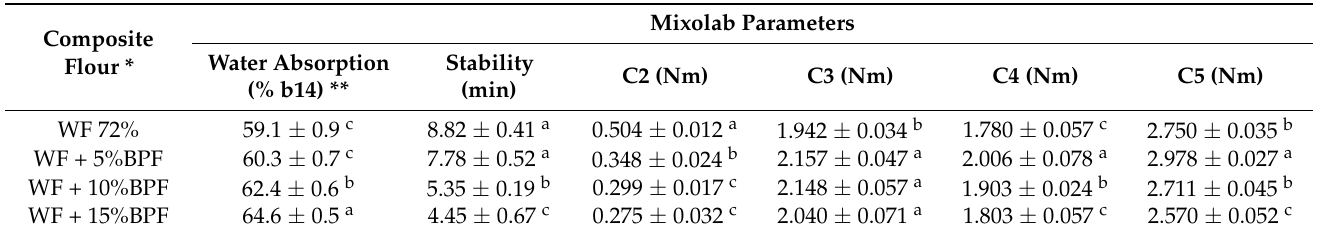
Table 7. Water absorption and stability of WF and substituted WF with BPF ( A. digitate ).